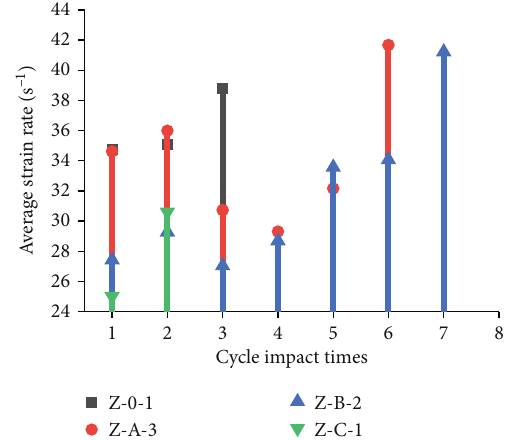
Figure 9: Relationship between the average strain rate and number of